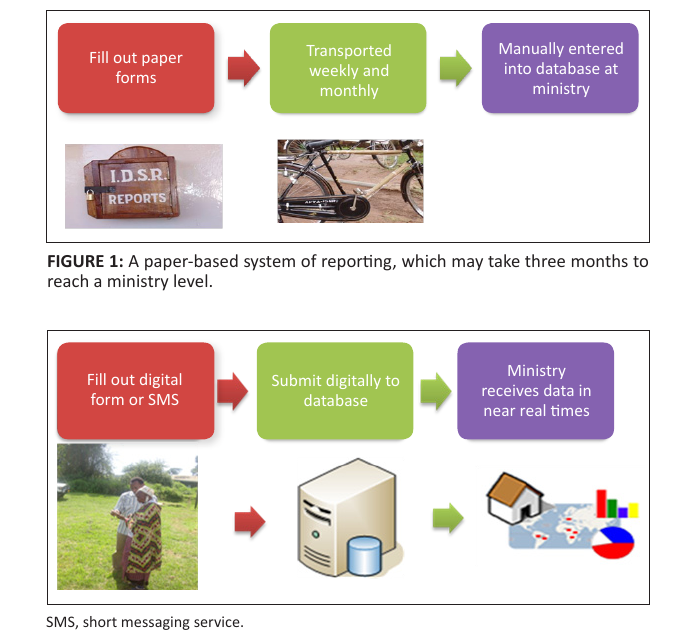
FIGURE 2: A proposed system in which digital and mobile technology is used to speed up the reporting process.